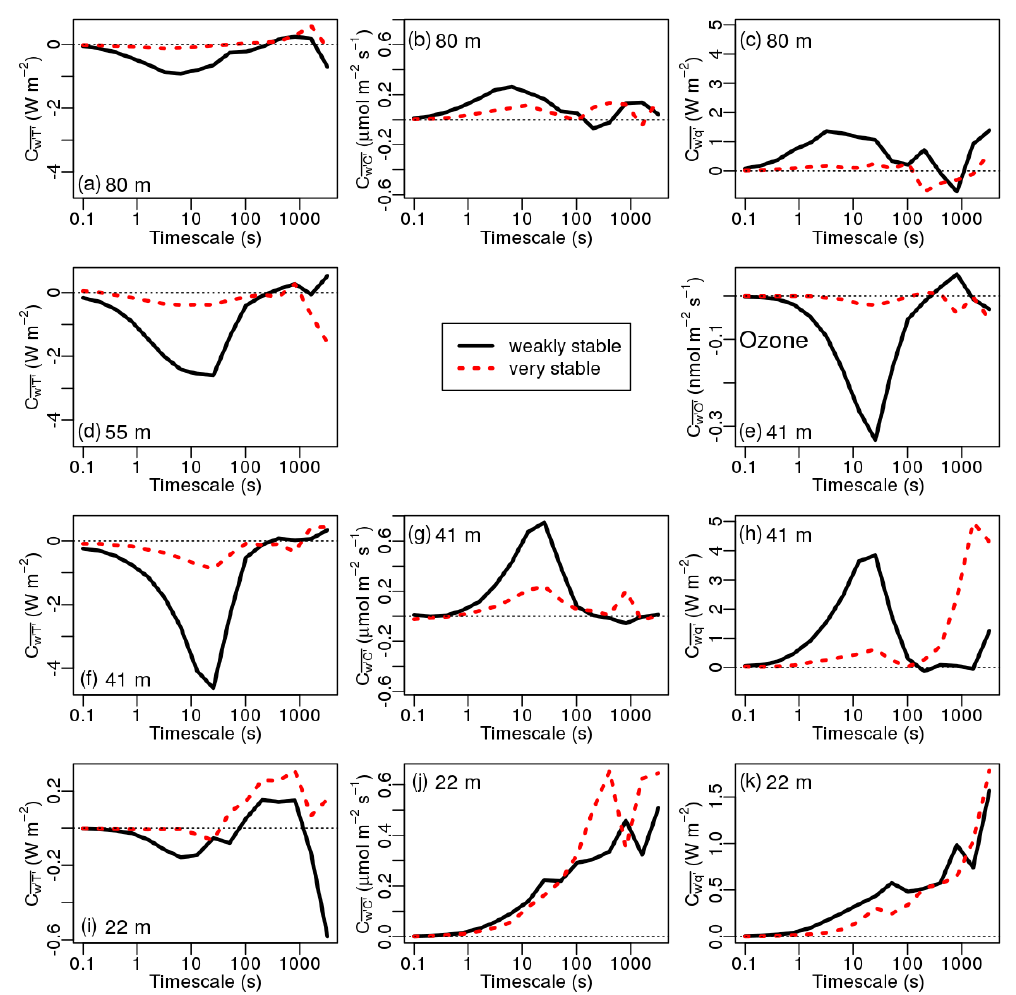
Figure 13. Average cospectra of sensible heat ( a , d , f , i ), CO 2 ( b , g , j ), O 3 (e) , and latent heat fluxes ( c , h and k ) for the weakly stable (black solid lines) and the very stable (red dashed lines) cases for all levels, as indicated in each panel. In all panels, averages are calculated for each